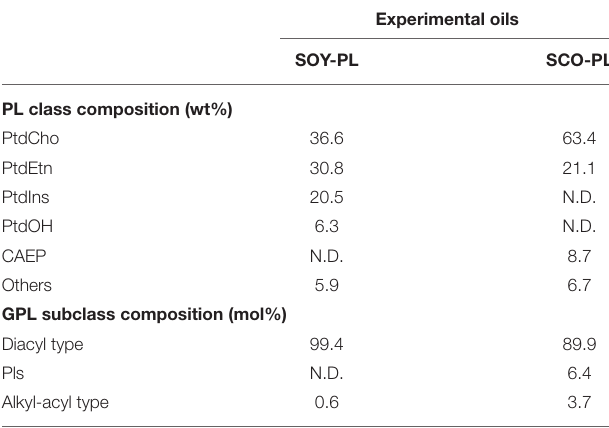
TABLE 2 | Phospholipids class and subclass composition of the experimental